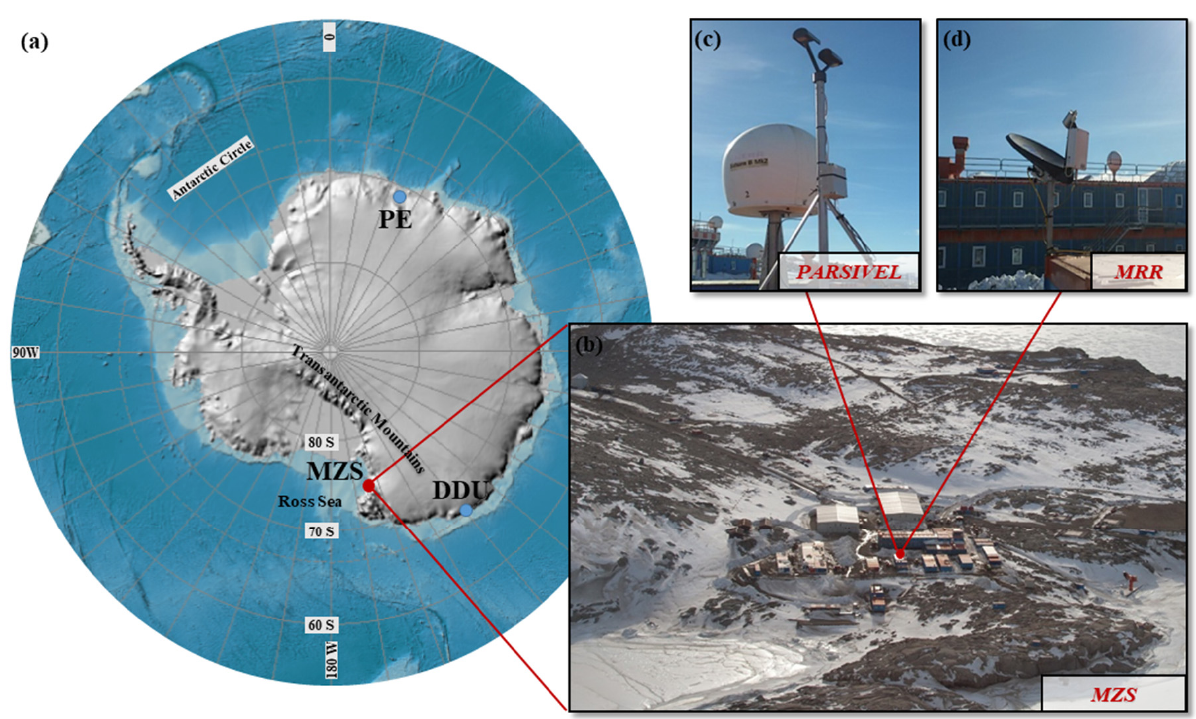
Figure 1. ( a ) Geographic map of the Antarctic continent with the locations of Mario Zucchelli (MZS), Dumont D’Urville (DDU), and Princess Elisabeth (PE) research stations (credit: Earthstar Geographics-PGC-UMN-Esri); ( b ) Aerial view of the Mario Zucchelli research station (credit: PNRA.aq) with the position of the co-located instrumentation used in this study, namely disdrometer ( c ) and radar ( d ).